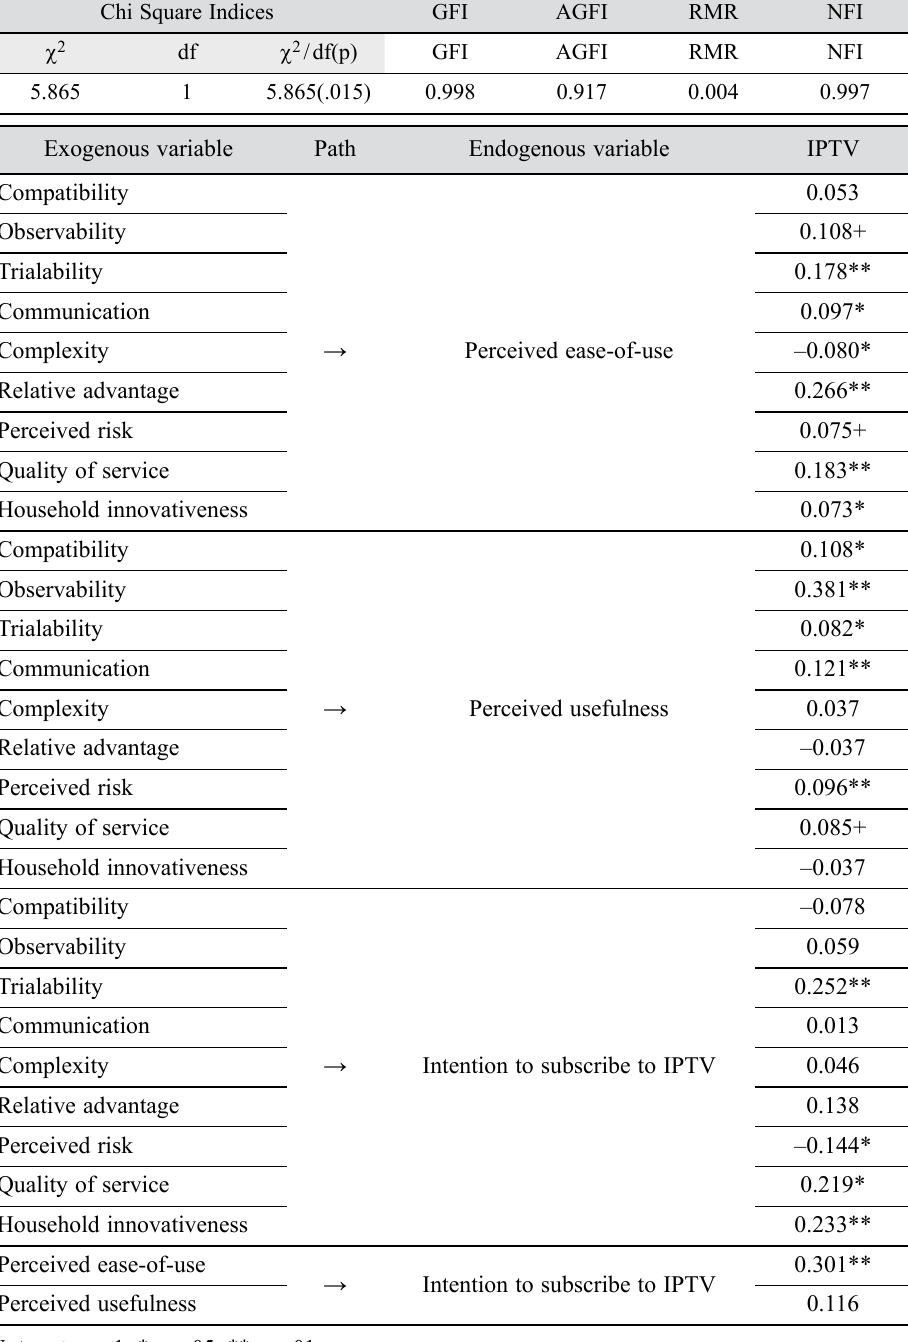
Table 3. Structural analysis of use-diffusion model on